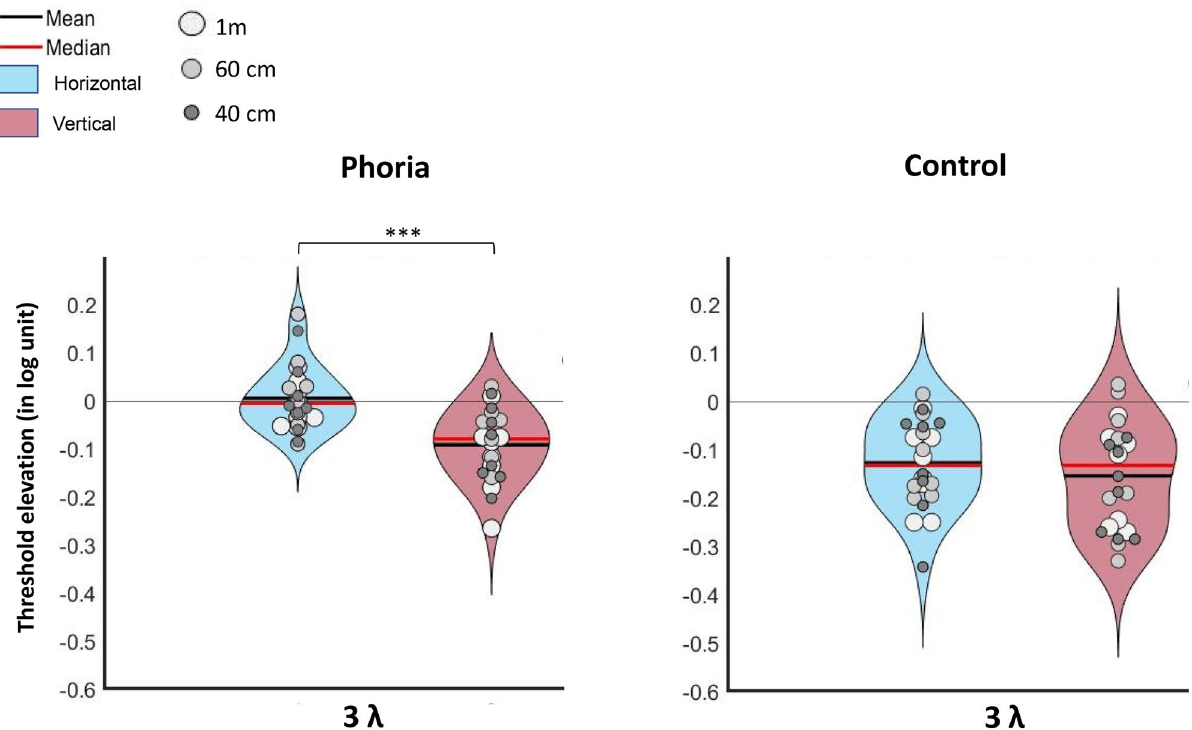
Figure 3. Violin plots represent the distribution of the threshold elevation (in log units) for a target separation of 3λ for the horizontal meridian (the orientation of a target of 0°, in blue) and the vertical meridian (the orientation of a target of 90°, in red). Facilitation is indicated by values below zero, and suppression by values above zero. The results were obtained in experiment 1. The threshold elevations represented were averaged for all the distances. The graph on the left represents the results obtained for the heterophoric group (n = 8), and the graph on the right represents the control group (n = 8). Big-sized circles in light gray denote the threshold elevation for each participant at 1-m viewing distance; middle-sized circles in medium gray denote the threshold elevations for each participant at 60 cm viewing distance, and the little circles in dark gray denote the threshold elevations for each participant at 40 cm viewing distance *** p ≤ 0.001, ** p ≤ 0.01, * p ≤